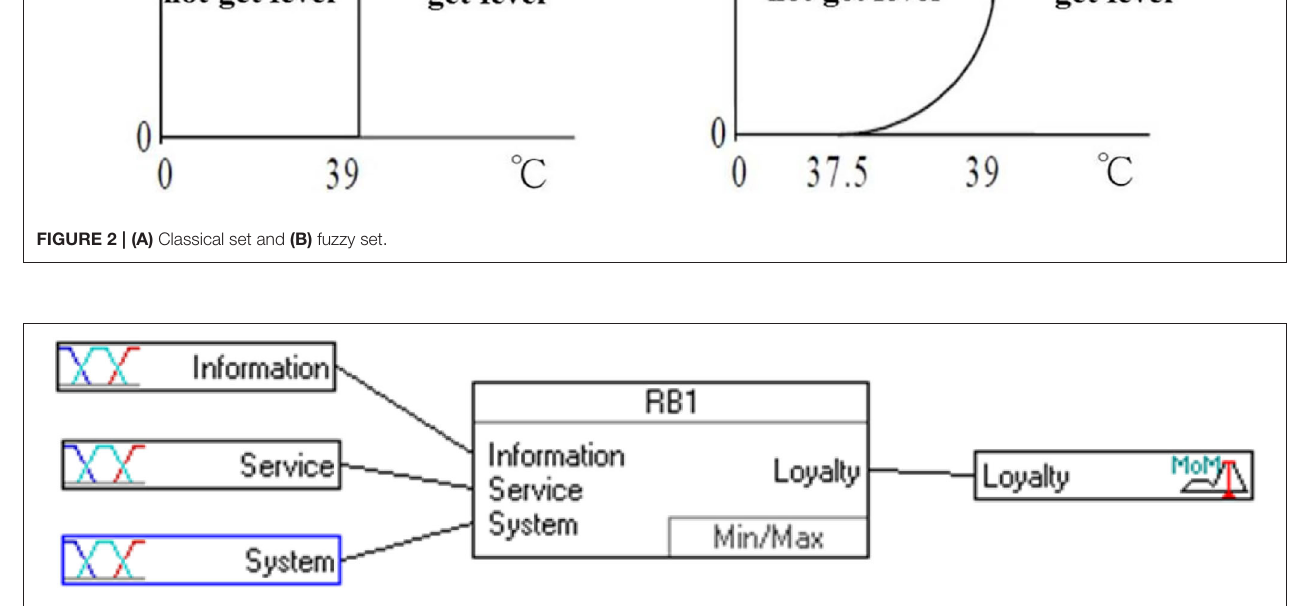
FIGURE 3 | The proposed